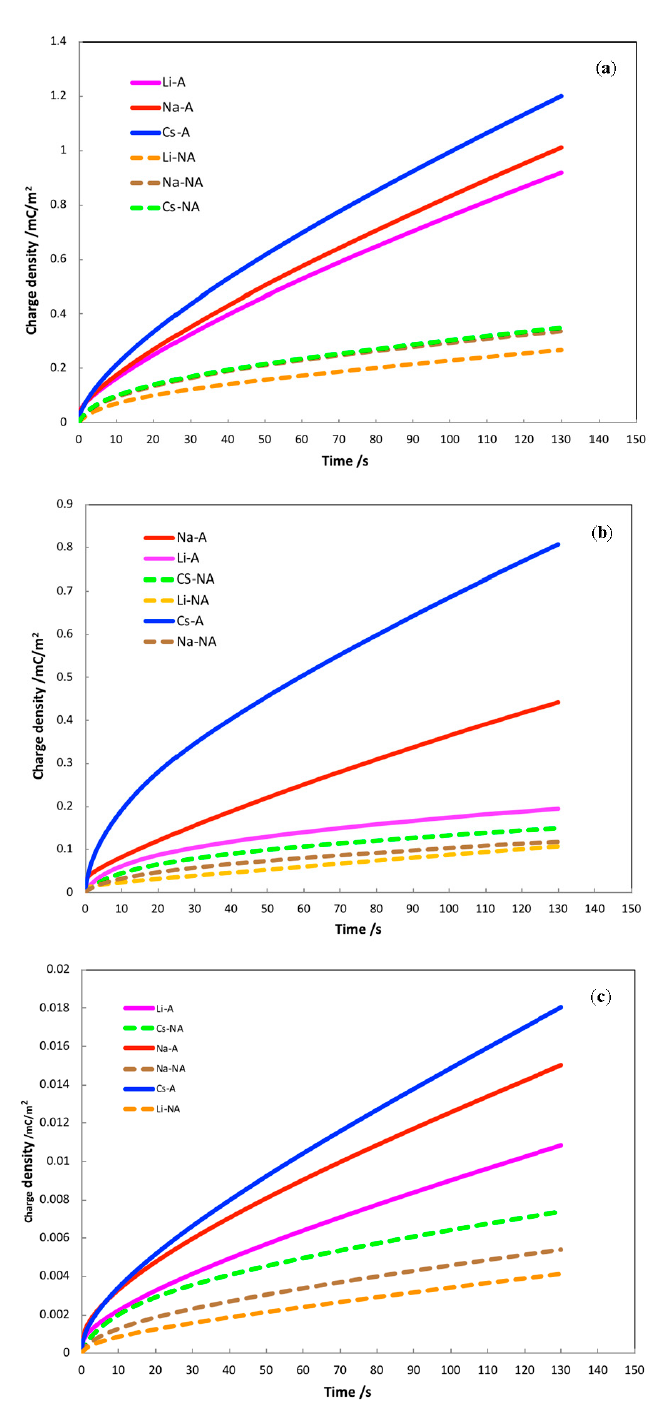
Figure 3. Charging rate of Li + , Na + , and Cs + with TiO 2 -NT-A and TiO 2 -NT-NA under ( a ) − 600 mV vs. Ag/AgCl; ( b ) − 400 mV vs. Ag/AgCl; and ( c ) − 200 mV vs. Ag/AgCl (solid line for TiO 2 -NT-A and dashed line for TiO 2 -NT-NA).